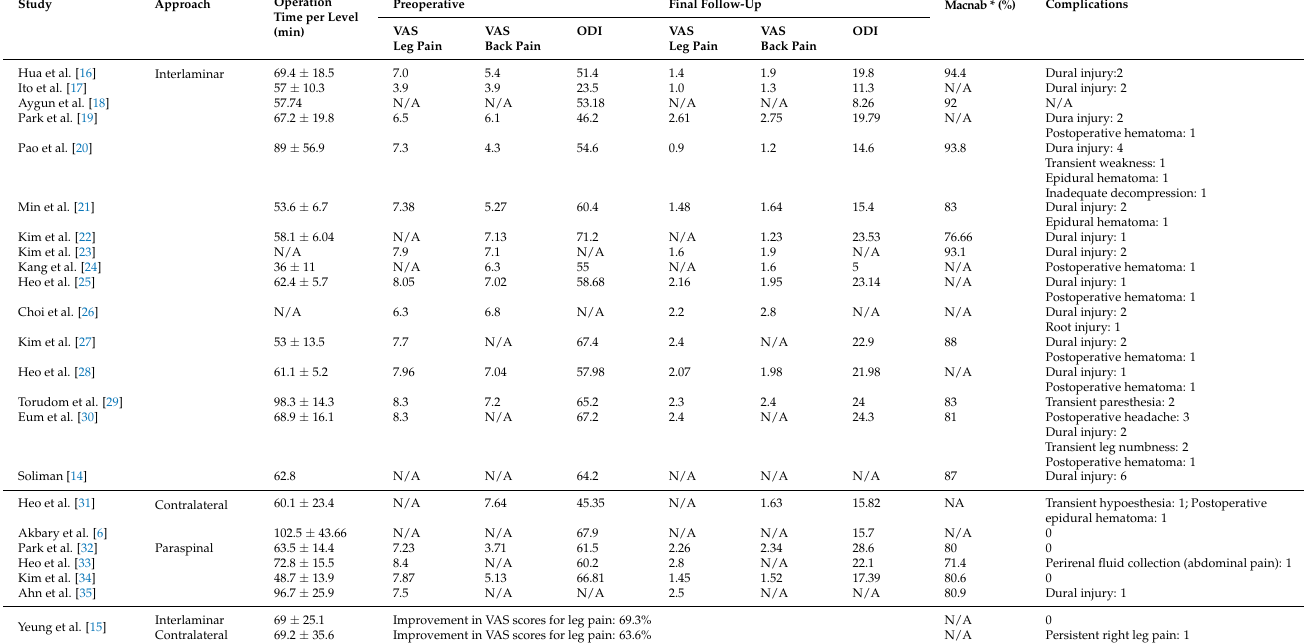
Table 4. Clinical outcomes indicated in the articles reviewed in the present study.